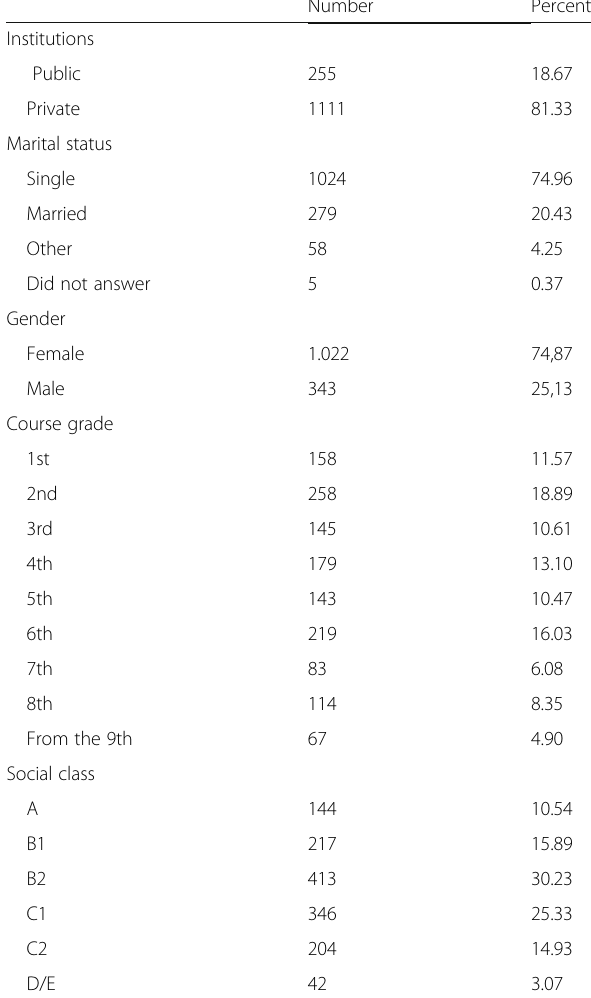
Table 3 Characterization of the